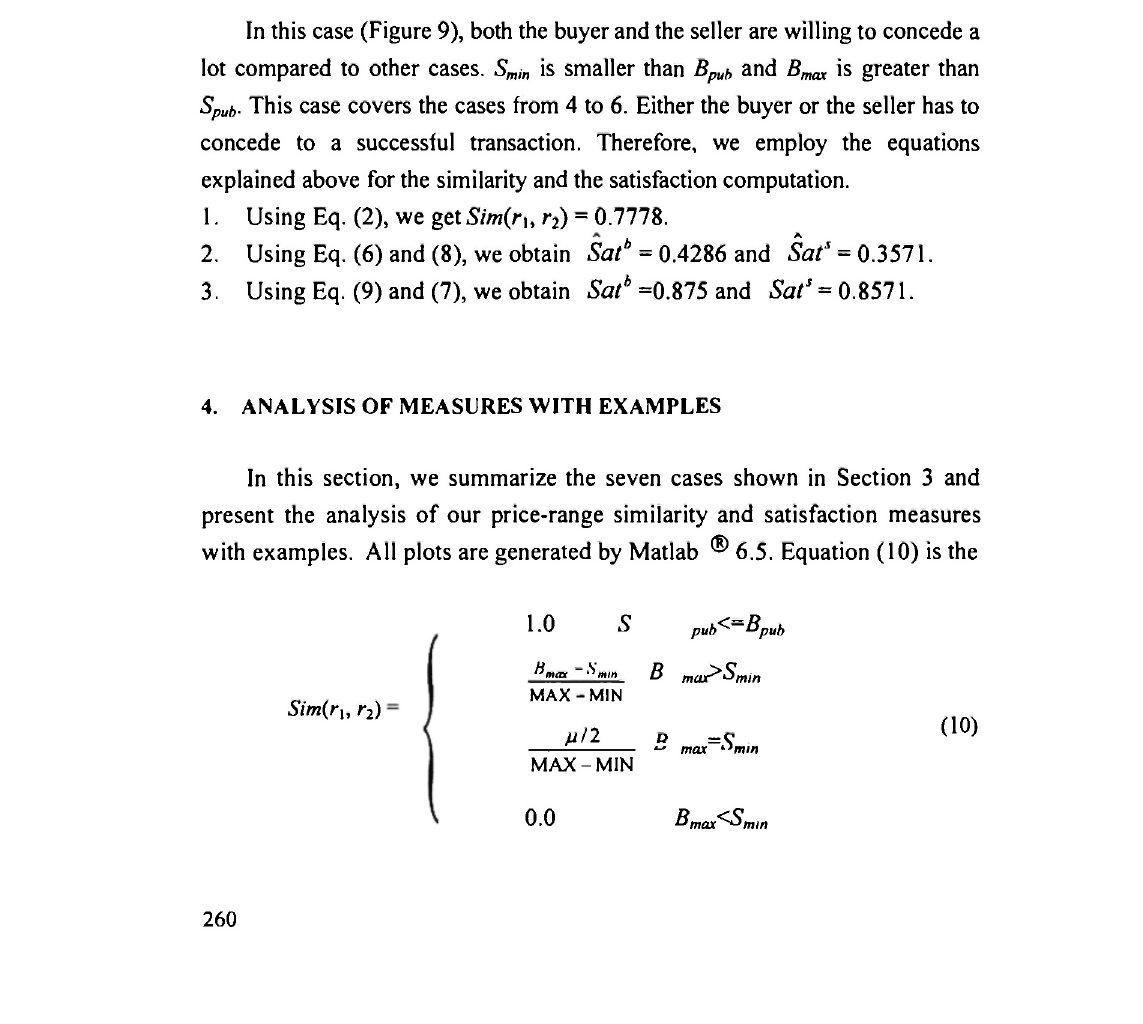
Fig. 9: Either the buyer or the seller has to conceded for successful